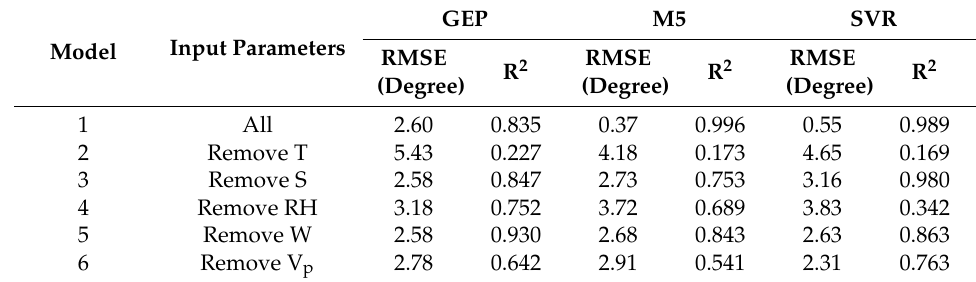
Table 6. Effect of removing input variables on the utilized model’s accuracy for predicting DPT